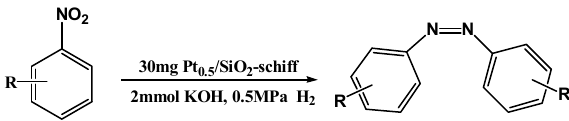
Cl KOH Figure 6. The mechanism of the hydrogenation of p -CNB to the corresponding DCAB. To confirm our proposed mechanism, a serial experiment of the hydrogenation of DCAOB and DCAB was performed. Indeed, hydrogenation of DCAOB to DCAB does not occur under weakly alkaline conditions even for a long period reaction time. With a strong base, DCAOB can be readily converted into DCAB with a high yield (98%) within 30 min. While the generated DCAB could not continue to be hydrogenated to 4,4'-dichlorohydrazobenzene or p -CNA under the given condition. As a result, DCAB is the major product in the selective hydrogenation of p -CNB reaction under strongly basic condition. To demonstrate the general applicability of this Pt/SiO 2 -Schiff catalyst, a series of nitroaromatic compounds in the synthesis of Aazo (Scheme 2) were tested. As shown in Table 3, most of the substituted nitrobenzenes can result in good performance, especially for the compounds with the presence of electron-withdrawing substituents. With an electron donative group such as alkyl